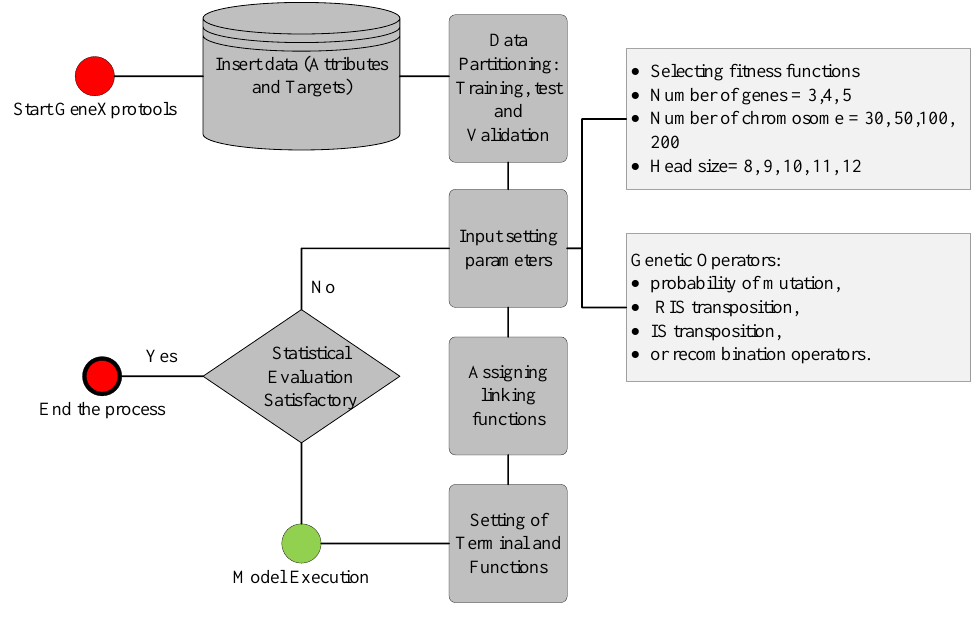
Figure 3. Flowchart of GEP modelling.